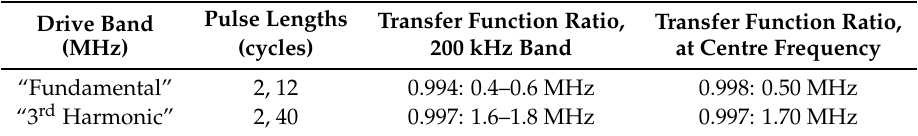
Table A1. Comparison of transfer function ratios for the H-107 (SN: 031) transducer system driven with short versus long pulses, in both driving frequencies of the